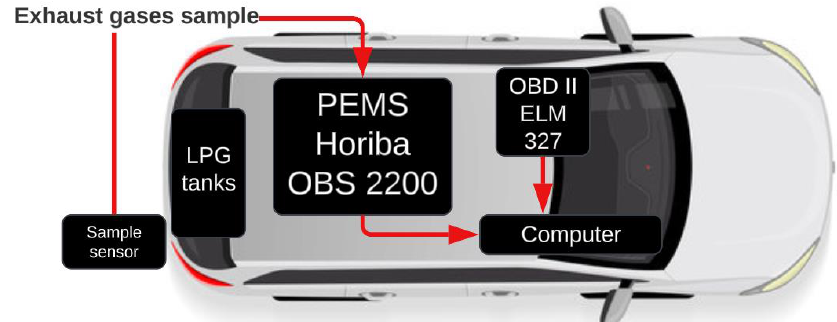
Figure 2. PEMS platform installed in the vehicle in the study.